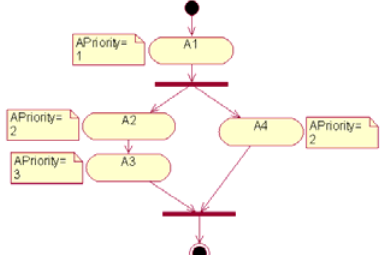
Fig. 6. Assigning APriority tag value for an activity diagram with fork or